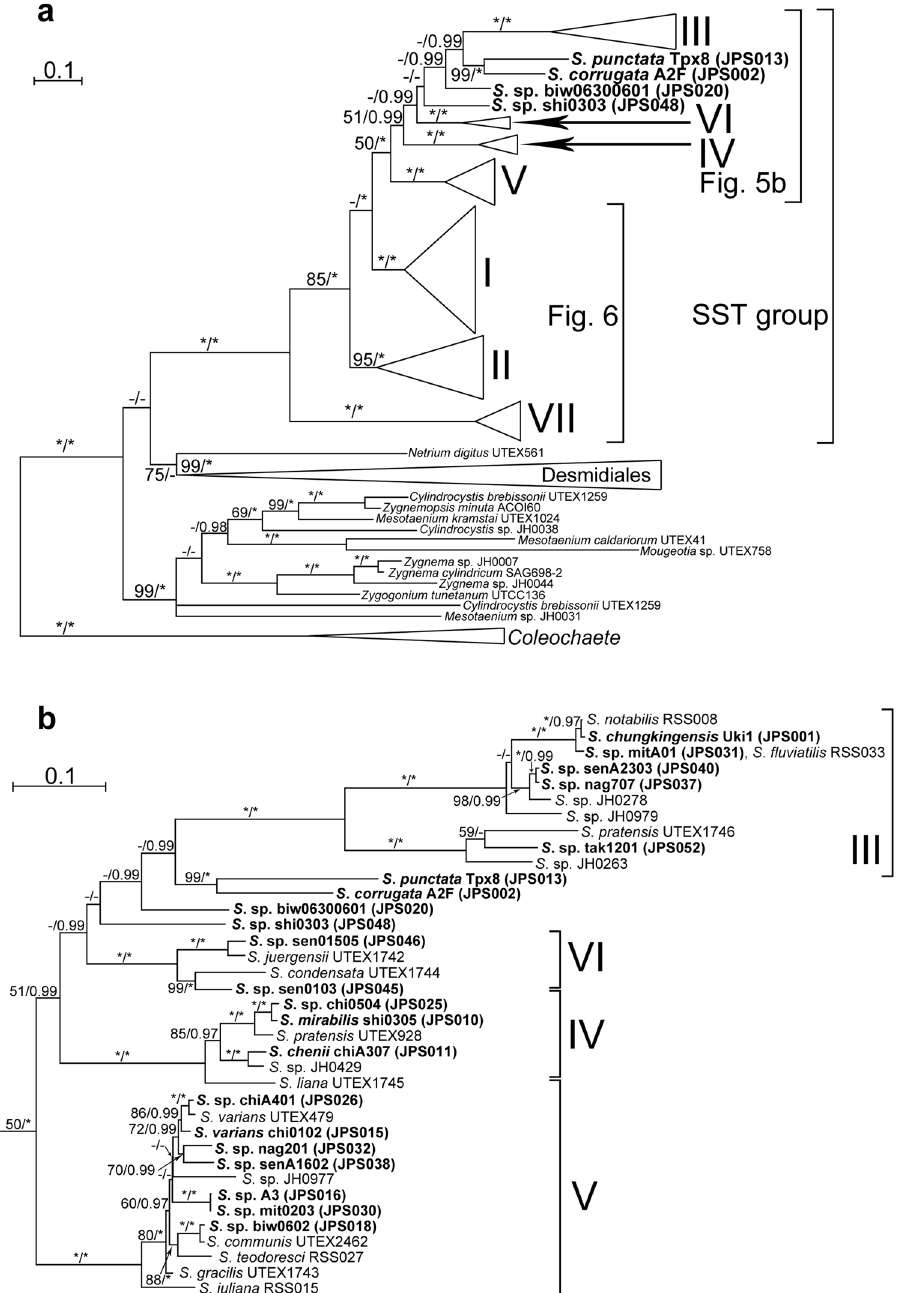
Figure 5. Maximum likelihood (ML) tree based on the combined data set from rbcL and atpB genes of 138 operational taxonomic units (OTUs) (zygnematophycean algae) and five outgroup OTUs ( Coleochaete ) (Supplementary Tables S1, S4) using RAxML 26 . Branch lengths are proportional to the evolutionary distances indicated by scale bar above the tree or subtree in each figure. Numbers at left and right sides above branches are bootstrap values (50% or more) by ML analysis and posterior probabilities (0.90 or more) by Bayesian inference (BI), respectively. Asterisk represents 100% bootstrap values by ML method or 1.00 posterior probability by BI. OTU designations in boldface represent 52 rbcL -types from Japan (Supplementary Table S1). Note that OTUs of I–VII correspond to those of Clades I–VII of Stancheva et al . 11 and “ S . sp.” may belong to Temnogyra or Sirogonium because of lack of sexual reproduction characteristics. ( a ) Overview of the ML tree based on rbcL and atpB concatenated dataset. Details of “Desmidiales” are shown in Supplementary Fig. S5. ( b ) Details of part of the ML tree ( a ) showing Clades